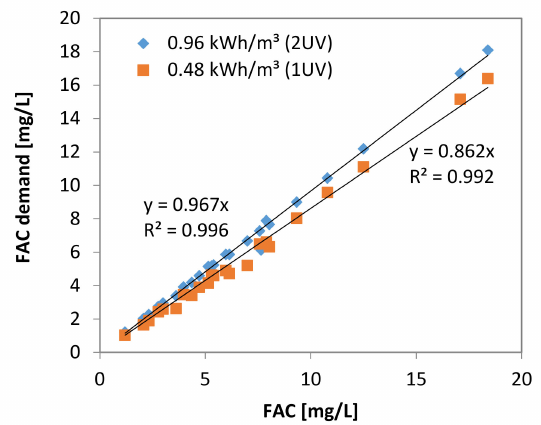
Figure 7. Chlorine consumption by UV treatment in dependence of FAC (Q = 75 L / h, EC = 400 µ S / cm, T = 19 ± 1 ◦ C).